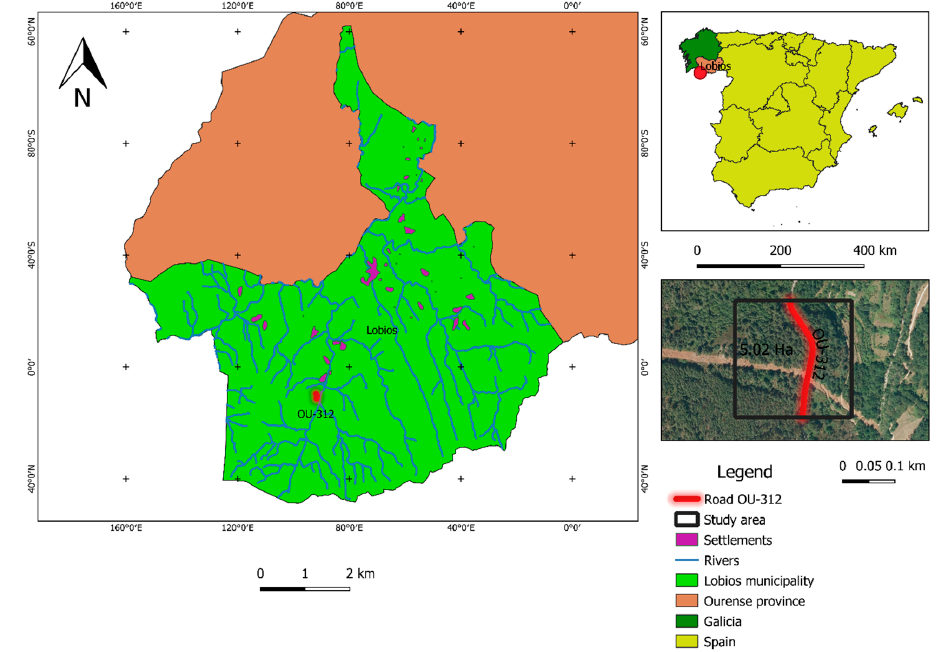
Figure 1. Location of OU-312 road.